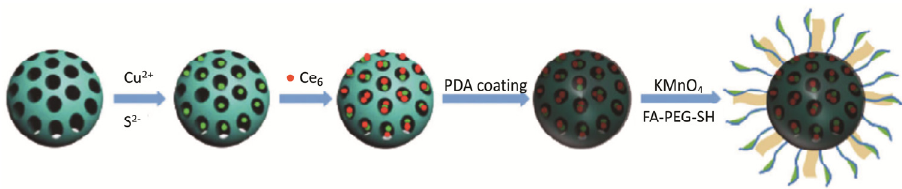
Figure 13. Representation of the nano-theranostic formulation for MRI and PTT/PDT dual therapy (reproduced from Reference [85] with permission from Springer